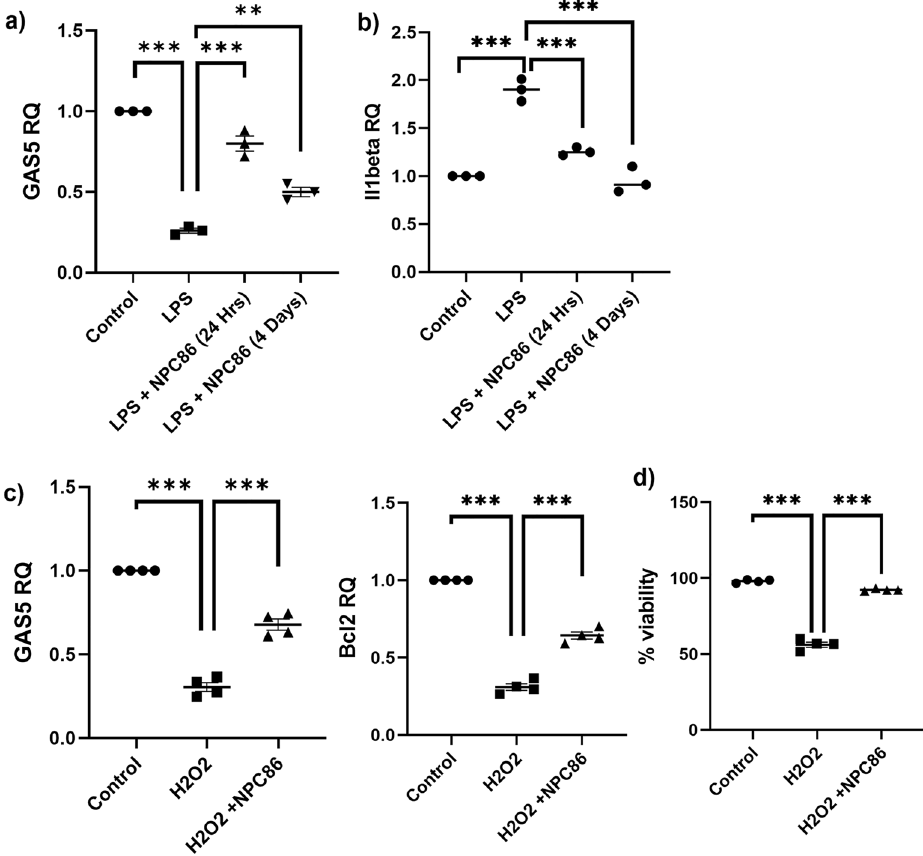
Figure 8. LPS chronic treatment decreases GAS5 in HT22. ( a ) HT22 cells were treated with LPS (5 ng/mL) for 4 days (LPS), HT22 cells were treated with LPS for 3 days followed by rescue with NPC86 treatment for 24 h (LPS + NPC86 (24 Hrs)) or NPC86 was added along with LPS for 4 days (LPS + NPC86 (4 days)). All cells were harvested on the fourth day, RNA was isolated, and qPCR was performed, normalized to β-actin expression and relative quantification (RQ) was determined for GAS5 and ( b ) IL1β, with control set as reference (n = 3). Statistical analysis was performed by one-way ANOVA, **p < 0.01, ***p < 0.001. ( c ) HT22 cells were treated with 100 μM H2O2 (1 h) followed by NPC86 treatment (7 h). RNA was isolated, qPCR was performed, normalized to β-actin expression and relative quantification (RQ) was determined for GAS5 and Bcl2 with control set as reference (n = 4). Statistical analysis was performed by one-way ANOVA, ***p < 0.001. d) HT22 cells were treated with 100 μM H2O2 (1 h) followed by NPC86 treatment (7 h). Acridine orange (AO) and propidium iodide (PI) dual staining was used to determine the viability of HT22 cells ( n = 4). Statistical analysis was performed by one- way ANOVA, ***p <